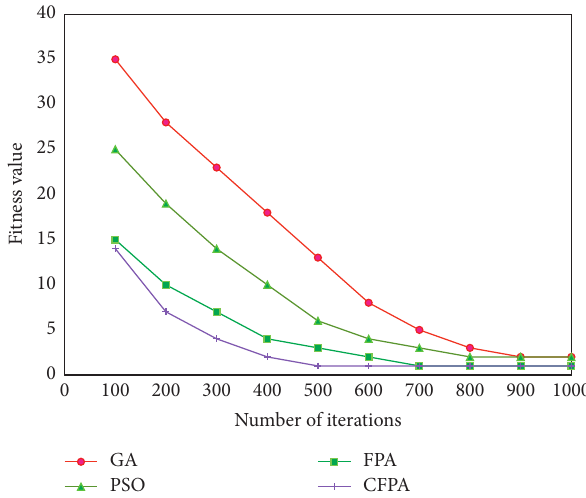
Figure 2: Four algorithms for fitness value under f 1 function.